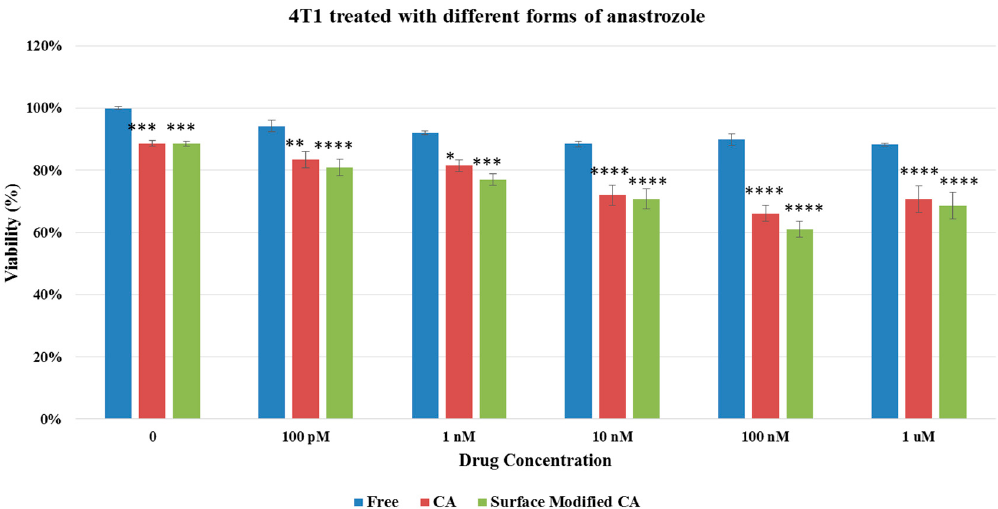
Figure 7. Cell viability of MCF7 after 48 h of treatment with anastrozole-loaded CA and surface modified, gemcitabine-loaded CA. Surface-modified CA denotes the particles modified with streptavidin–biotin–PEG and fibronectin. Values were significant (*) at p value 0.01 to 0.05, very significant (**) at p value 0.001 to 0.01, extremely significant (***) at p value 0.0001 to 0.001, and extremely significant (****) at p value < 0.0001.